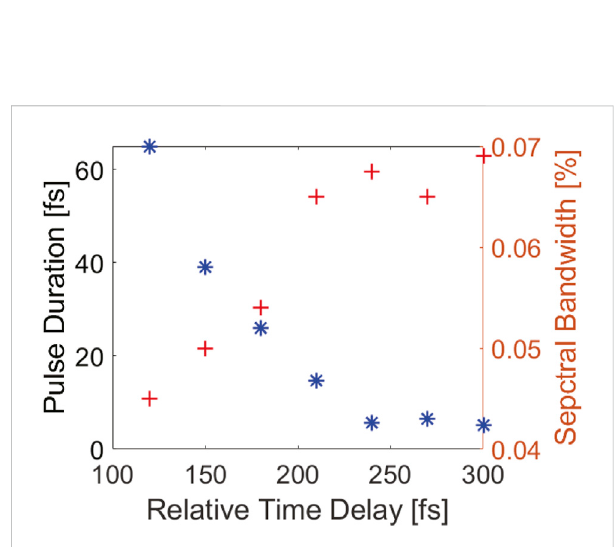
FIGURE 8 FEL pulse duration and spectral bandwidth with respect to different relative time delays between the two seed